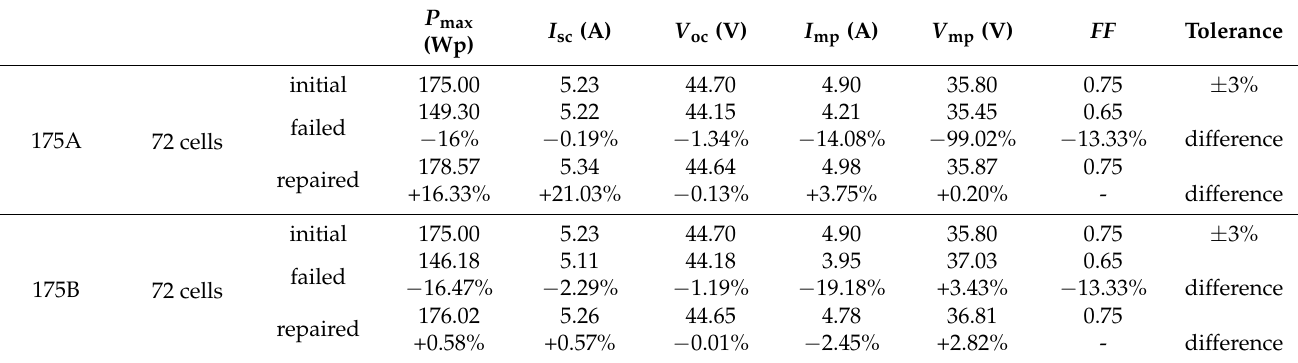
Table 2. Electrical characteristics of 175A and 175B samples at each stage.